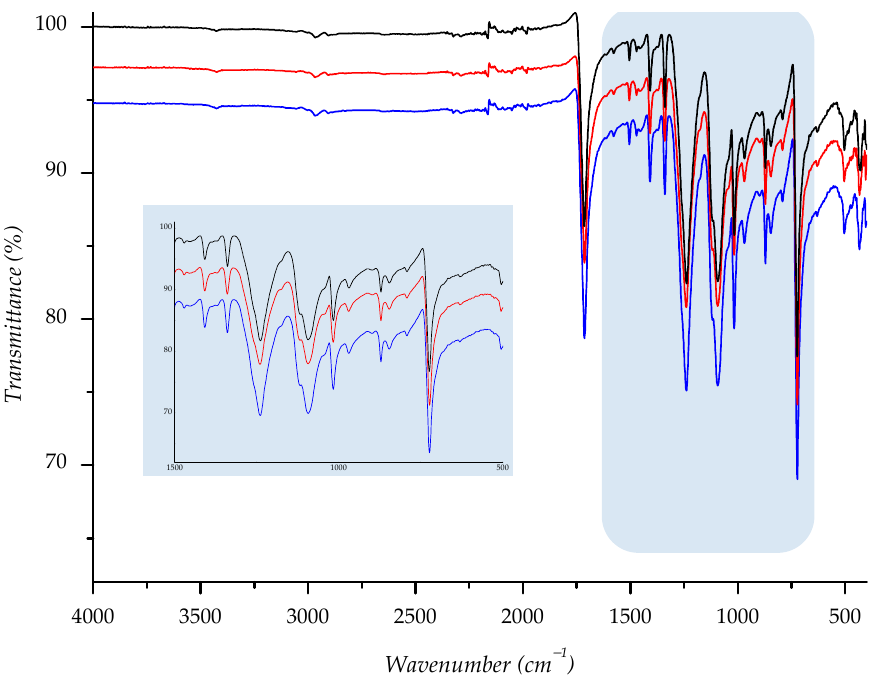
Figure 16. IR spectra of investigated sample F3 ((—) = starting material; (—) = material aged in sun; (—) = material aged in shade) with enlarged fingerprint region (colored in blue).